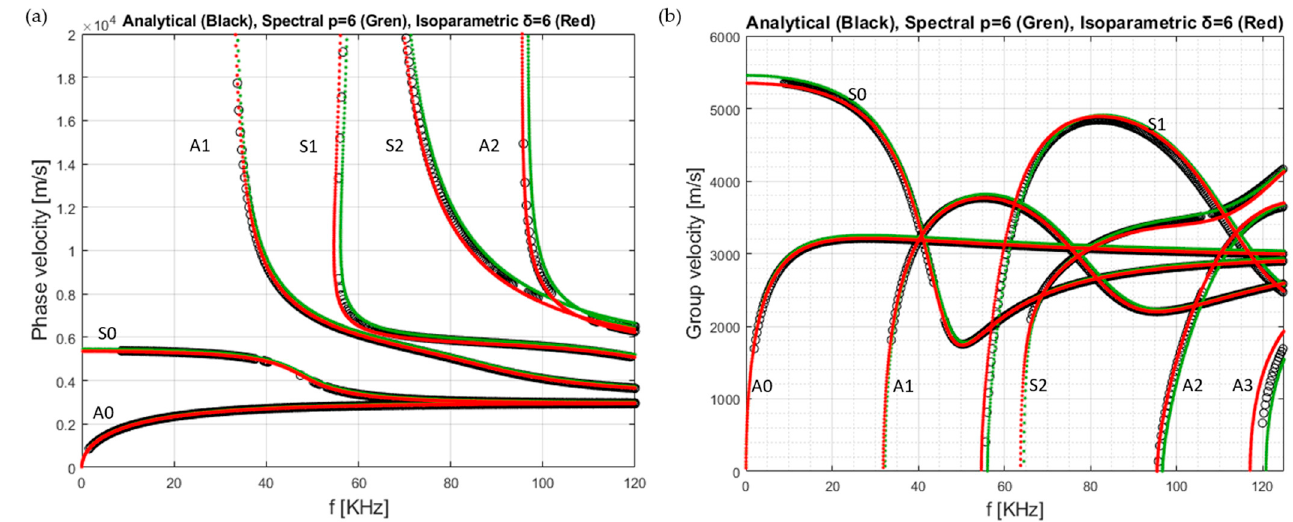
Figure 7. Dispersion curves given by the SBFEM method with isoparametric and spectral elements for a 50 mm-thick isotropic plate. ( a ) Phase velocity. ( b ) Group velocity. Symmetric Sn and antisymmetric An (n = 0, 1, 2,…) modes.